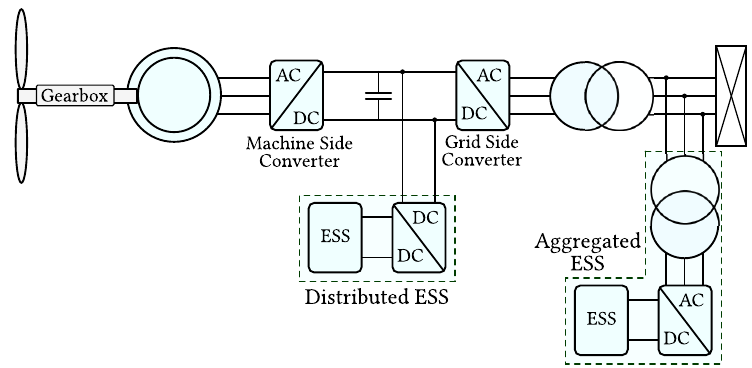
Figure 20. Configurations of energy storage systems at the wind farm level: distributed ESS and aggregated